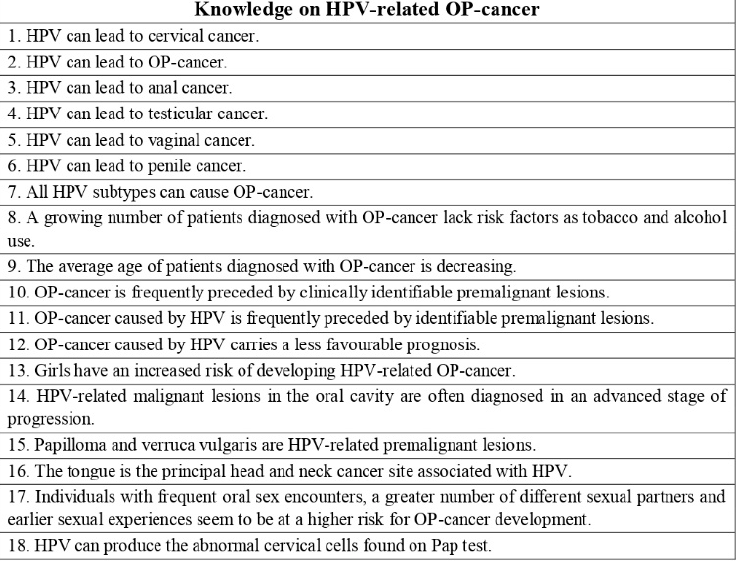
Figure 1. Questionnaire assessing pediatric dentists’ knowledge on HPV-related OP-cancer. Statements used required one of the following responses: “true”/“false”.